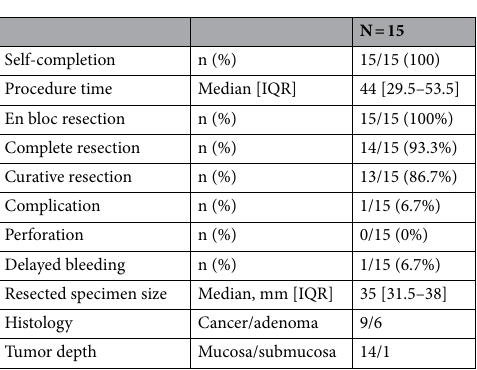
Table 2. Treatment outcomes of S-ESD for colorectal neoplasms. S-ESD, self-completion endoscopic submucosal